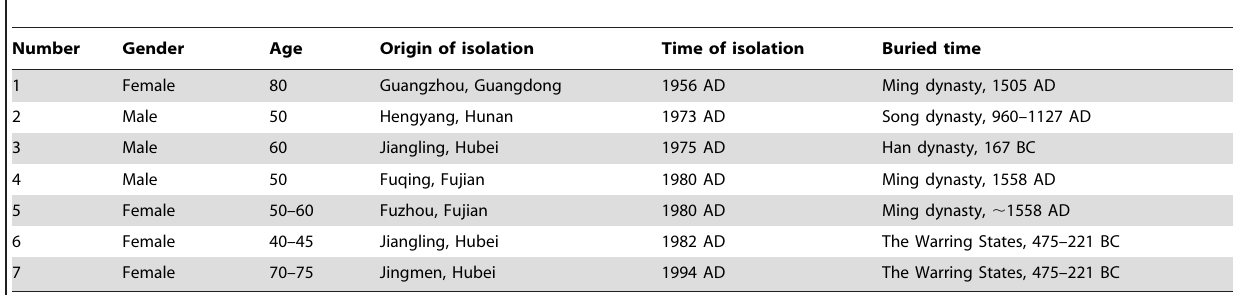
Table 6. Summarized archaeological evidence of C. sinensis eggs in desiccated fecal remains in mummies according to archived archaeology